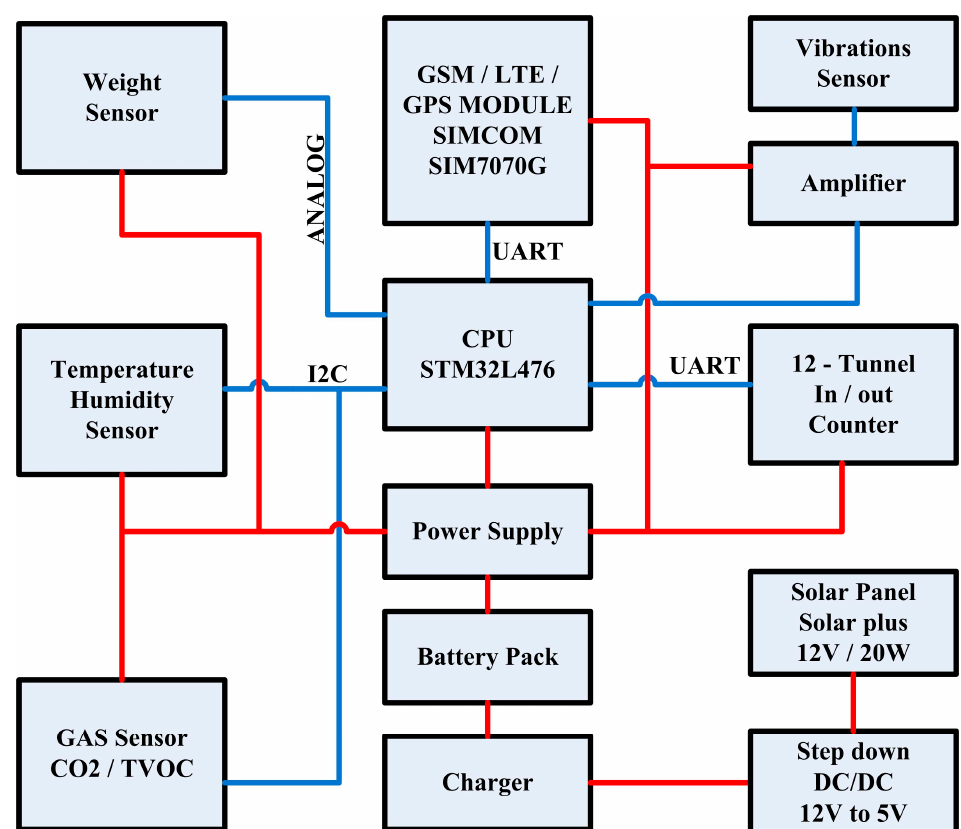
Figure 2. Block diagram of the e-beehive’s multichannel recorder. The system is controlled by an STM32L476RG ARM CPU of ST that simultaneously picks up the vibrations, the bee traffic in the entrance, the gas sensors (CO 2 , TVOC), the environmental variables, the vibrations and the measurements of a weight scale. All recordings, are stored in the SD card and transmitted through the LTE module. The device is powered by a 20 W solar panel that charges a battery pack of 12,000